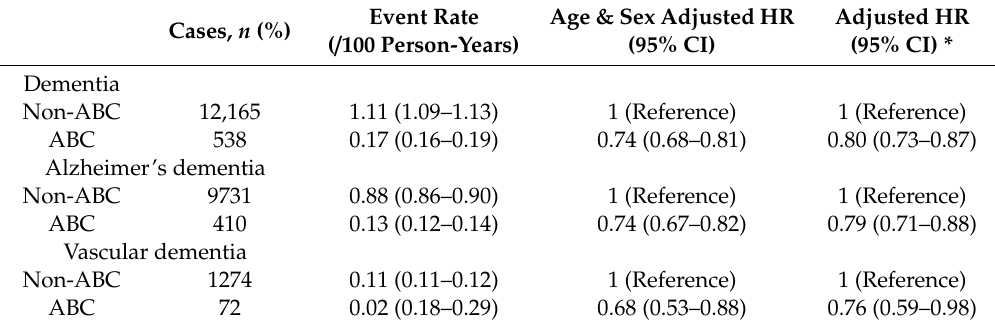
Table 3. Dementia, Alzheimer’s, and vascular dementia hazard ratios for the non-ABC vs. ABC groups.